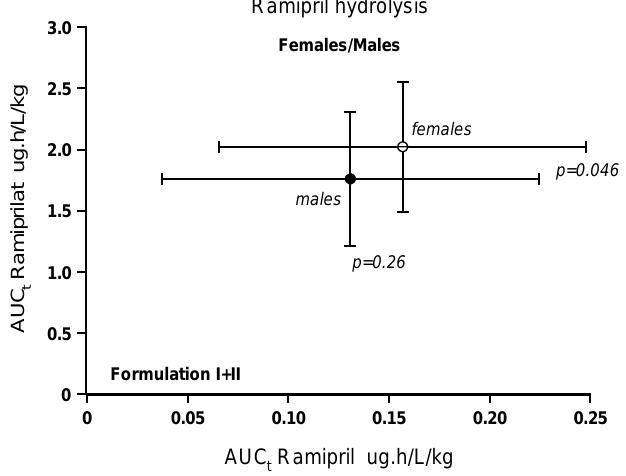
FIGURE 3 . AUC t/ kg ramipril plotted vs. the AUC t /kg of the metabolite ramiprilat after the oral administration of 5 mg ramipril (Formulation I + II). There is a difference between males (solid dot, n = 32) and females (open dot, n = 36) in the hydrolysis of ramipril ( p = 0.046).